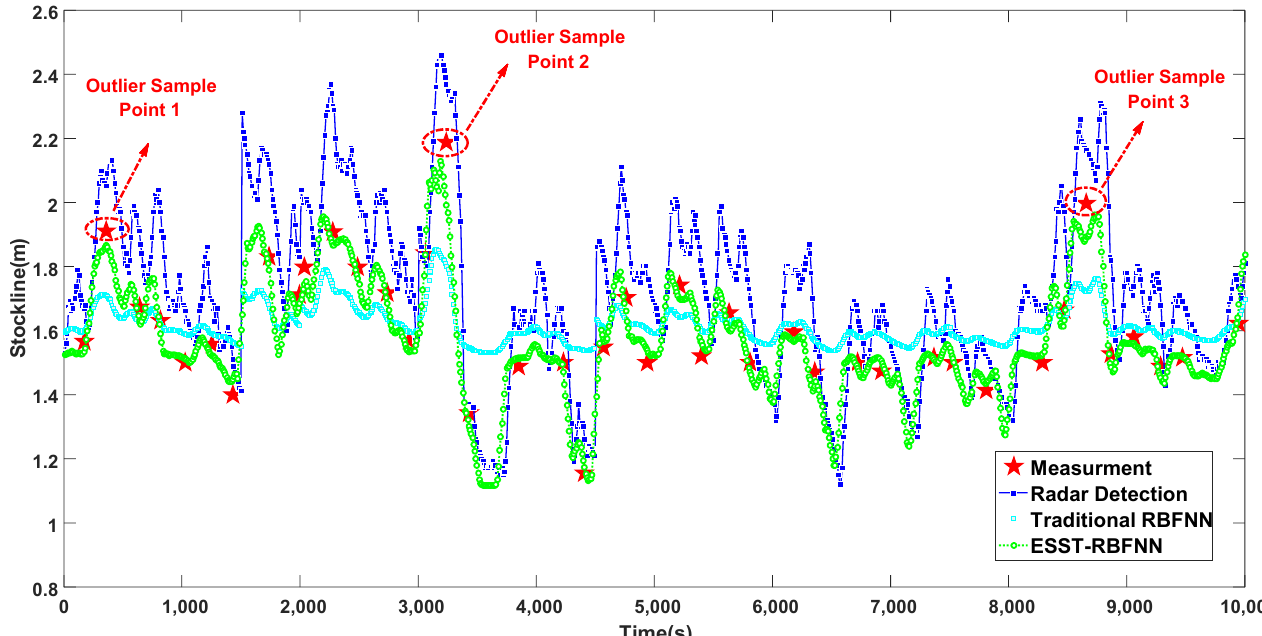
Figure 10. Comparison chart of different methods for measuring blast furnace burden level under abnormal working conditions.